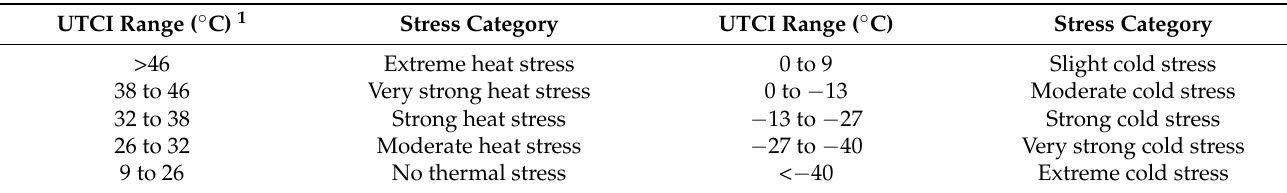
Table 2. The UTCI equivalent temperature classifies thermal